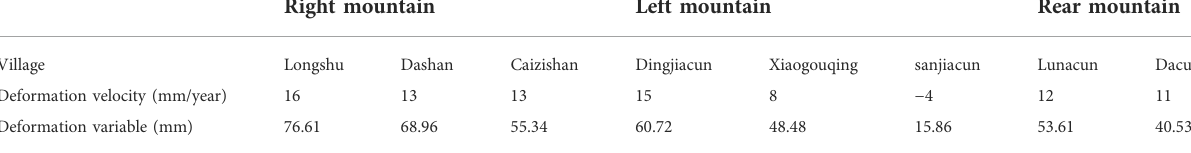
TABLE 6 Deformation velocity and variable of eight villages in the study area. Right